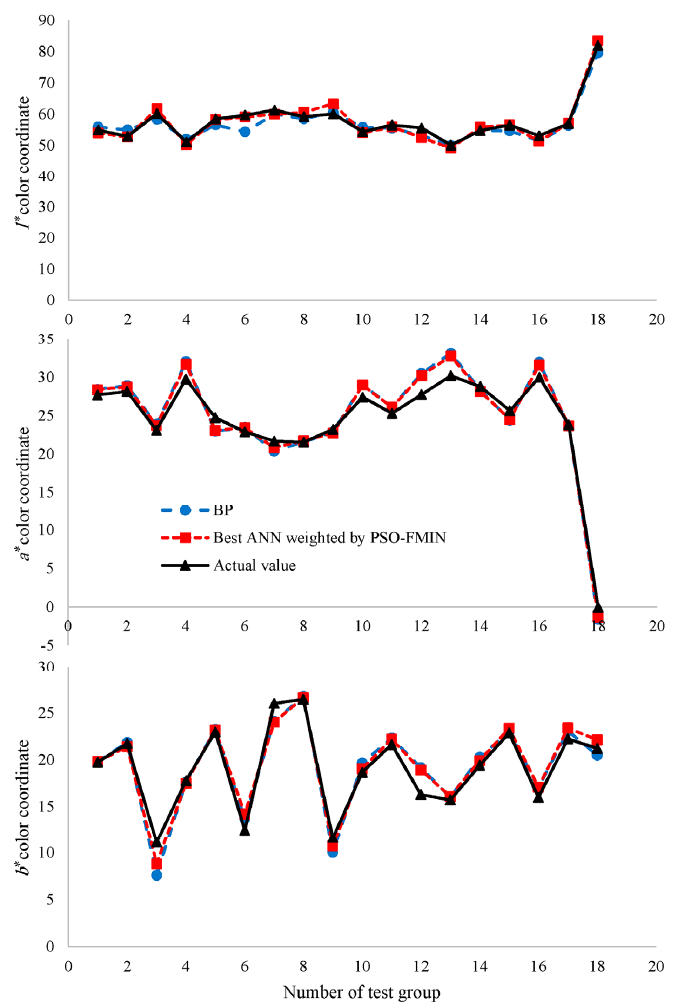
Figure 5. Outputs of the ANNs weighted by BP and PSO-FMIN algorithms and actual values for the test groups.